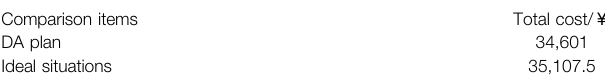
TABLE 3 | DA cost and ideal situation cost.